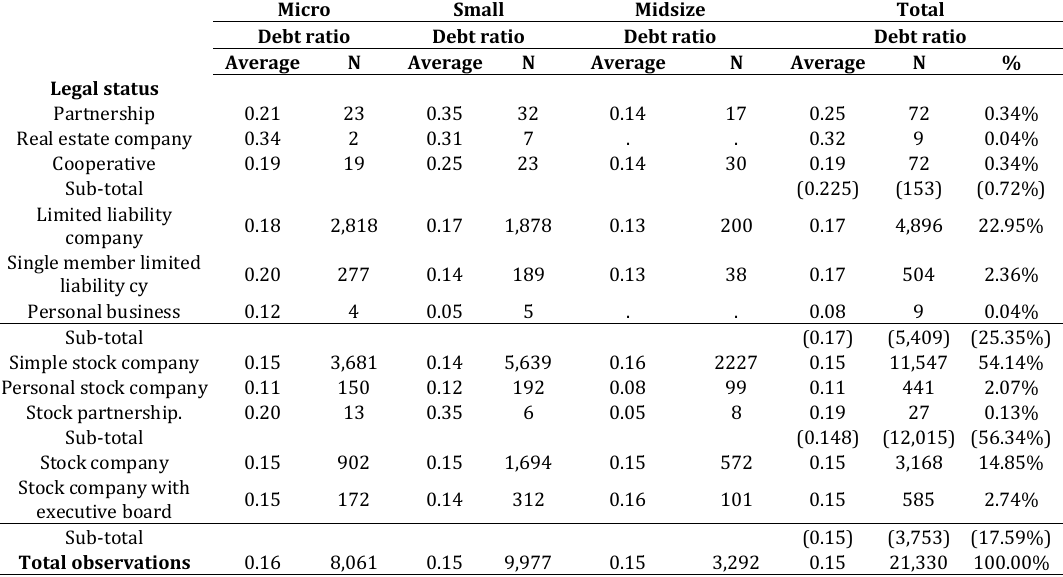
Table A3: distribution of SMEs categories according to their legal status and debt ratio (2002- 2010)